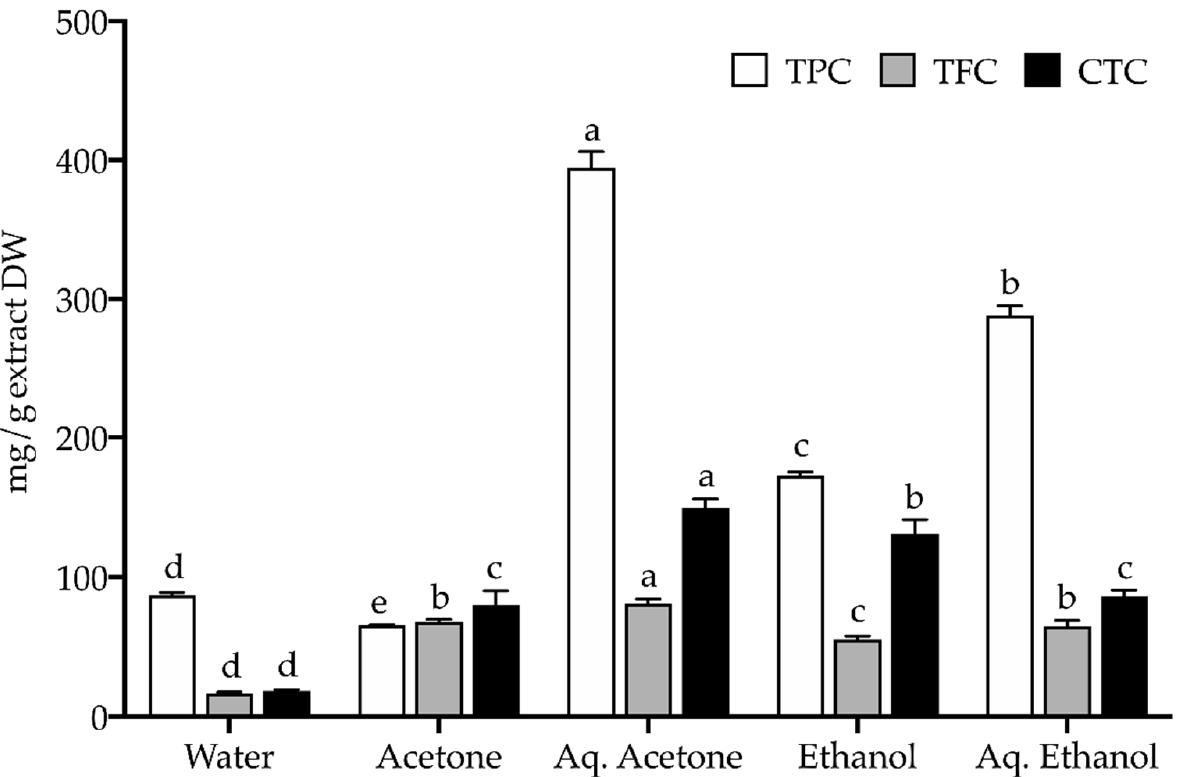
Figure 2. Polyphenolic contents (mg/g extract DW) in extracts of seeds from Cladium mariscus (sawgrass): Total phenolic content (TPC, mg GAE/g DW), Total flavonoid content (TFC, mg QE/g DW), and Condensed tannin content (CTC, mg CE/g DW). Values represent the mean ± SD ( n = 6). For each phenolic group, different letters “a–e” represent significant differences ( p < 0.05).